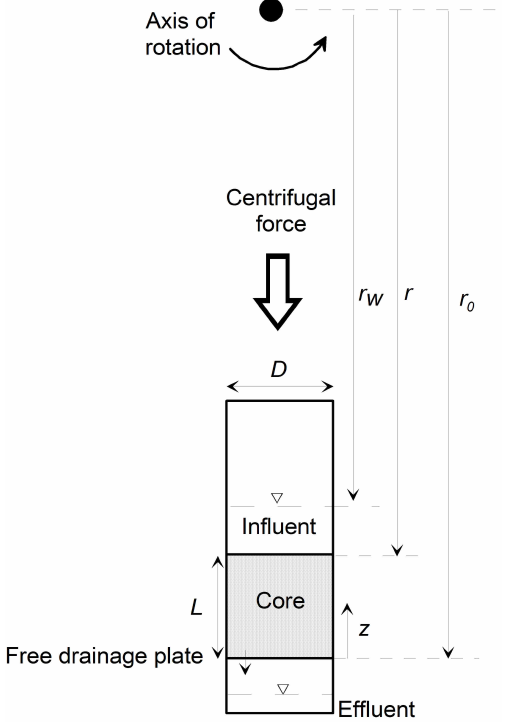
Figure 2. Cross sectional diagram of a core sample subjected to centrifugal force, with a free drainage boundary condition at the base of the